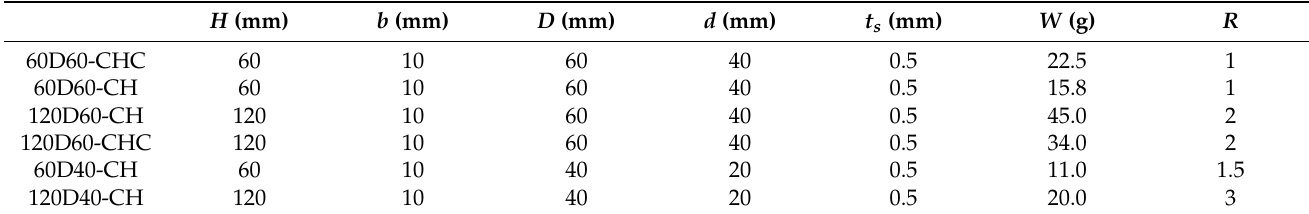
Table 2. Summary of the tested specimens.